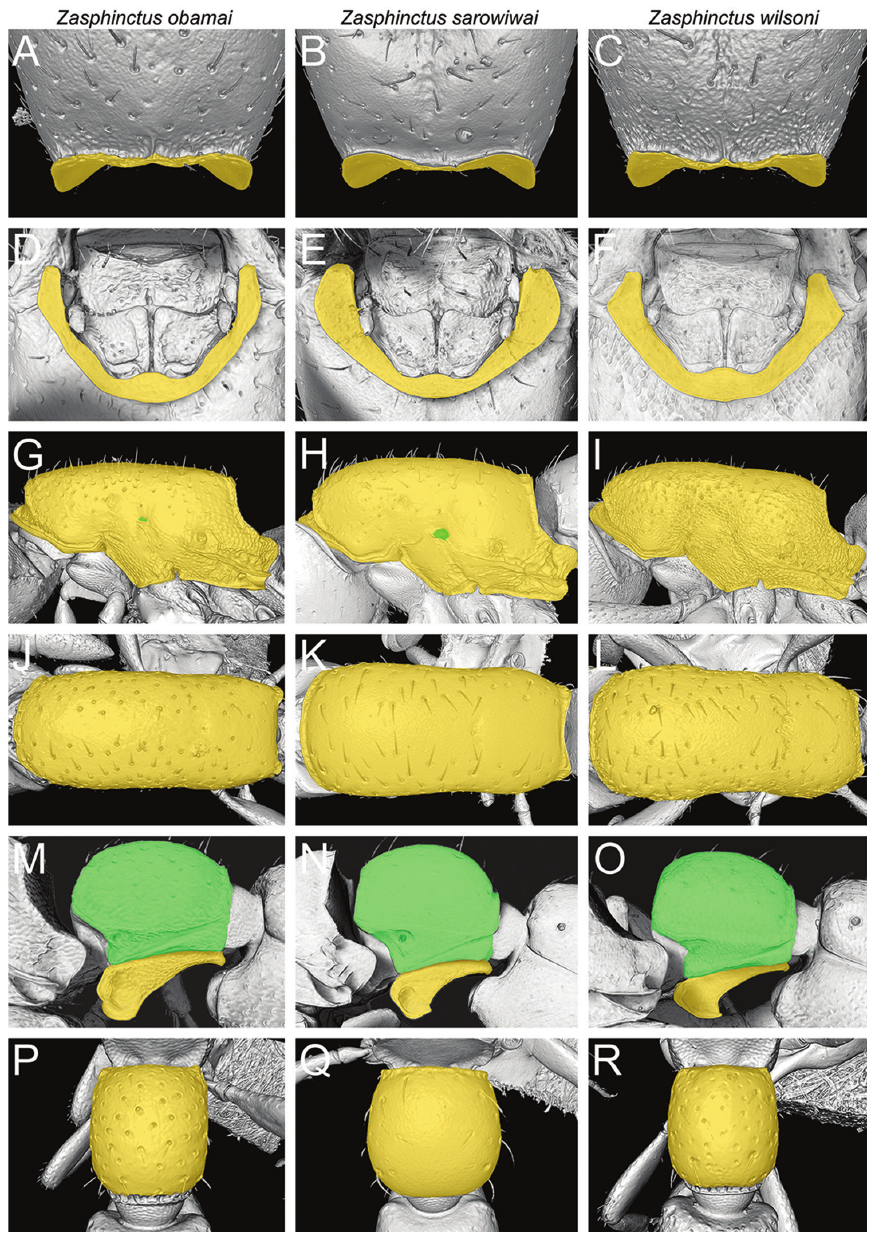
Figure 5. Illustrated diagnostic character matrix based on micro-CT images used for species delimita- tions ( Z. obamai = left column, Z. sarowiwai = middle column, Z. wilsoni = right column). A, B, C Pos- terior head in ventral view showing ventral occipital margin (virtually dissected) D, E, F Head in ventral view showing mouthparts and hypostoma (virtually dissected). G, H, I Mesosoma in profile (orange) with pleural endophragmal pit (green) J, K, L Mesosoma in dorsal view M, N, O Petiole in profile showing pet- iolar tergum (green) and petiolar sternum (orange) with subpetiolar process P, Q, R Petiole in dorsal